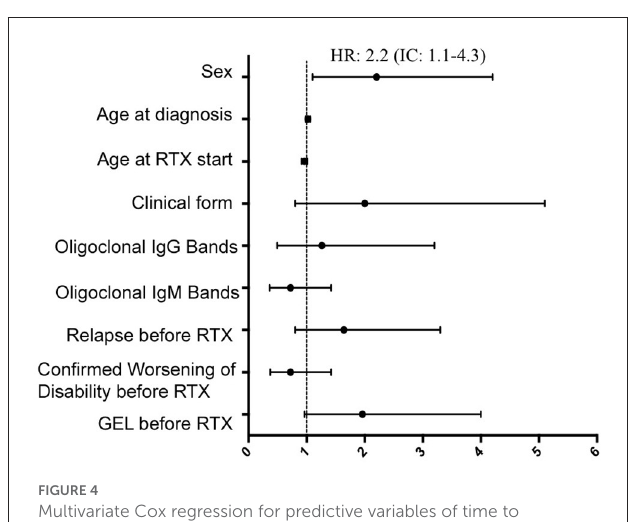
FIGURE4 Multivariate Cox regression for predictive variables of time to confirmed worsening of disability in the entire series. Risk for CWD status after RTX was greater in male patients. CWD, confirmed worsening of disability; GEL, gadolinium-enhanced lesions; RTX, rituximab.